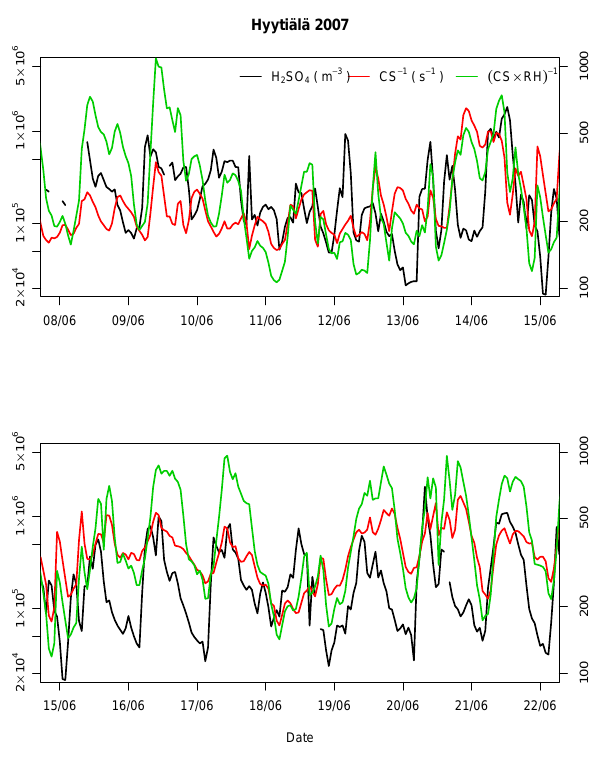
Fig. 5. Two week period of measurements of [H 2 SO 4 ] (left axis), CS − 1 and mean(RH) × (CS × RH) − 1 (right axis) in Hyyti¨al¨a 2007 dataset.